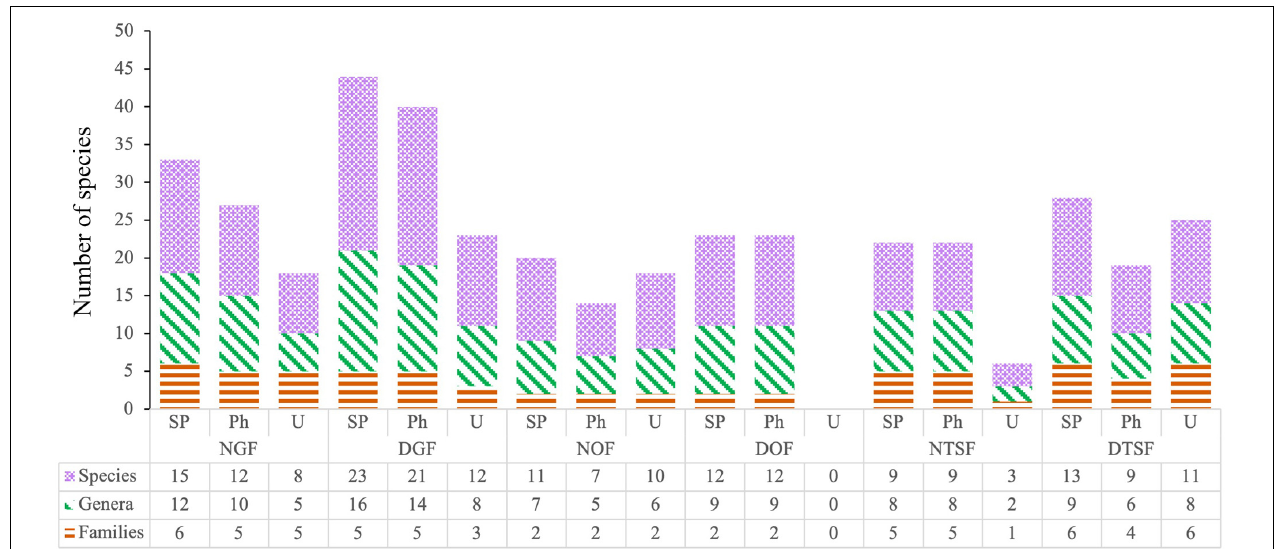
FIGURE 5 | Families, genera and species in the entire sampled plot (SP), phorophytes (Ph) and understory (U) per sampling site (NGF = natural gallery forest, DGF = disturbed gallery forest, NOF = natural oak forest, DOF = disturbed oak forest, NTSF = natural tropical sub-deciduous forest, DTSF = disturbed tropical sub-deciduous forest).